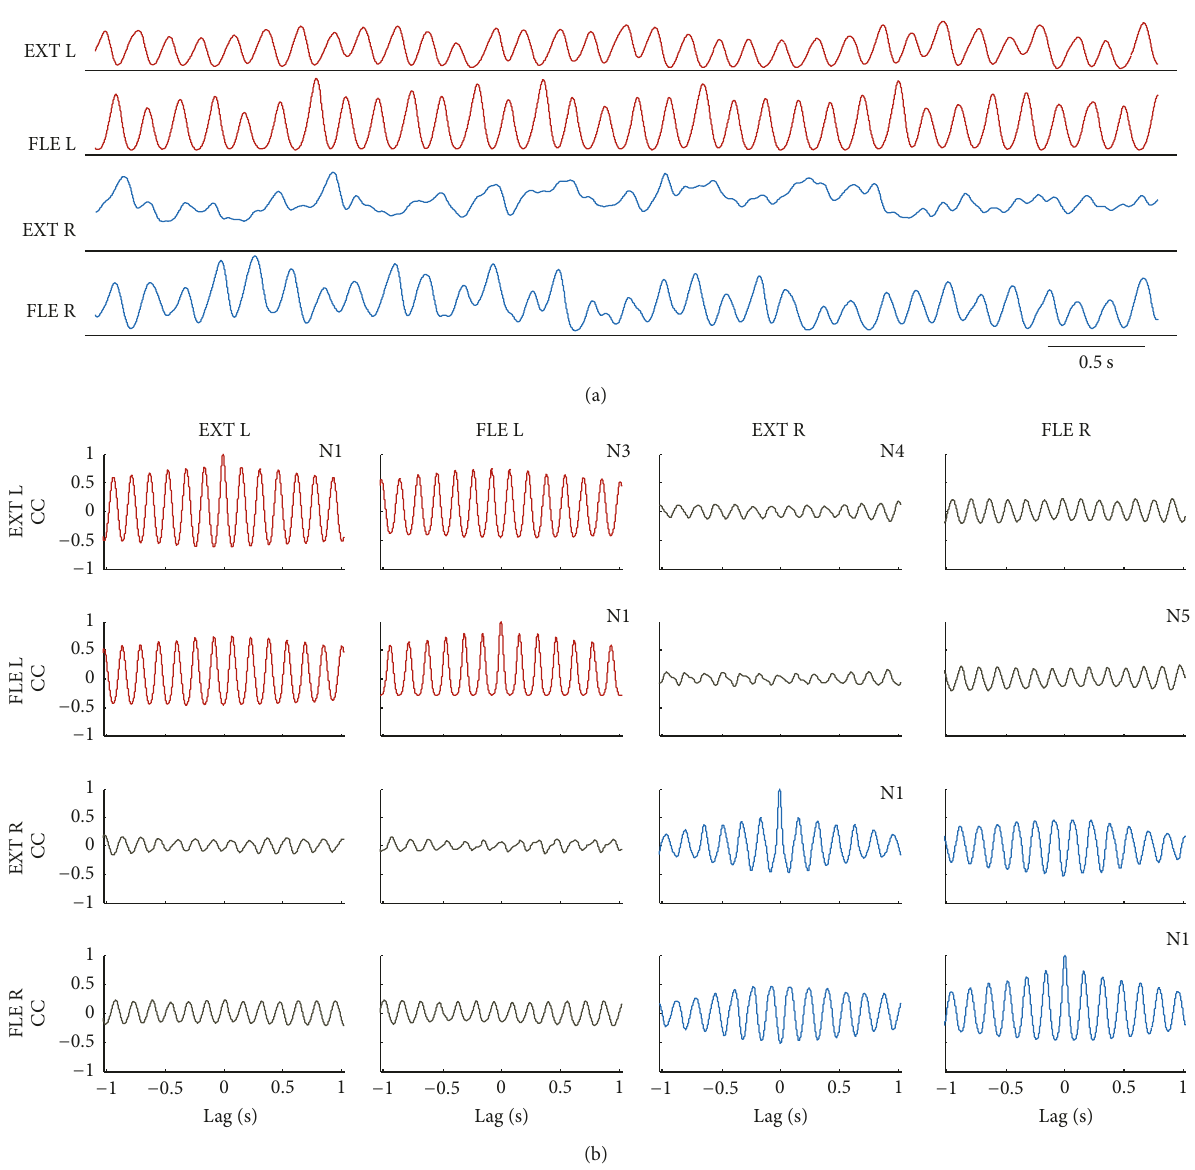
Figure 3: Neural drive to left and right wrist flexors and extensors in a representative ET patient during the arms outstretched task. (a) Neural drive as estimated by low-pass filtering of the cumulative motor unit spike train. All muscles exhibit tremulous drive, whereas voluntary drive is also present in the right extensor muscle. (b) Cross-correlations (CC) of neural drives; EXT L: left wrist extensors, FLE L: left wrist flexors, EXT R: right wrist extensors, and FLE R: right wrist flexors. The 𝑥 -axis denotes the correlation lag in seconds. Voluntary drive is filtered out, whereas the tremulous drive is enhanced by the correlation function. Data from panels N1, N3, N4, and N5 are included into the calculation of the N1, N3, N4, and N5 tremor symmetry metrics (see text for